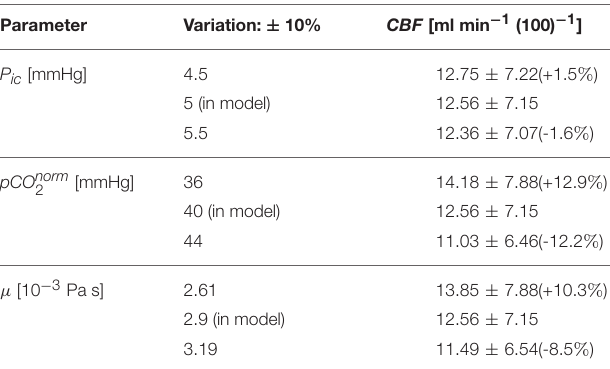
TABLE 7 | Effect of variations of input constant parameters on the model based CBF .